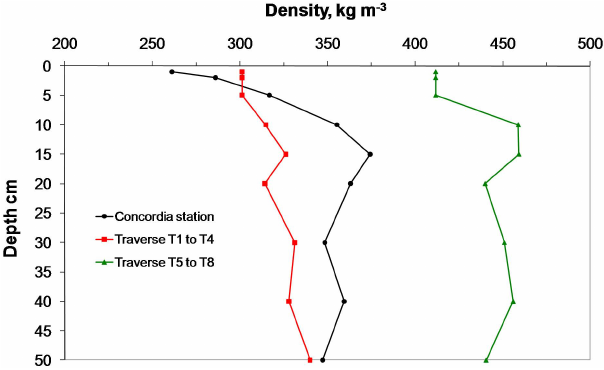
Fig. 11. Mean density profiles at DC and along the